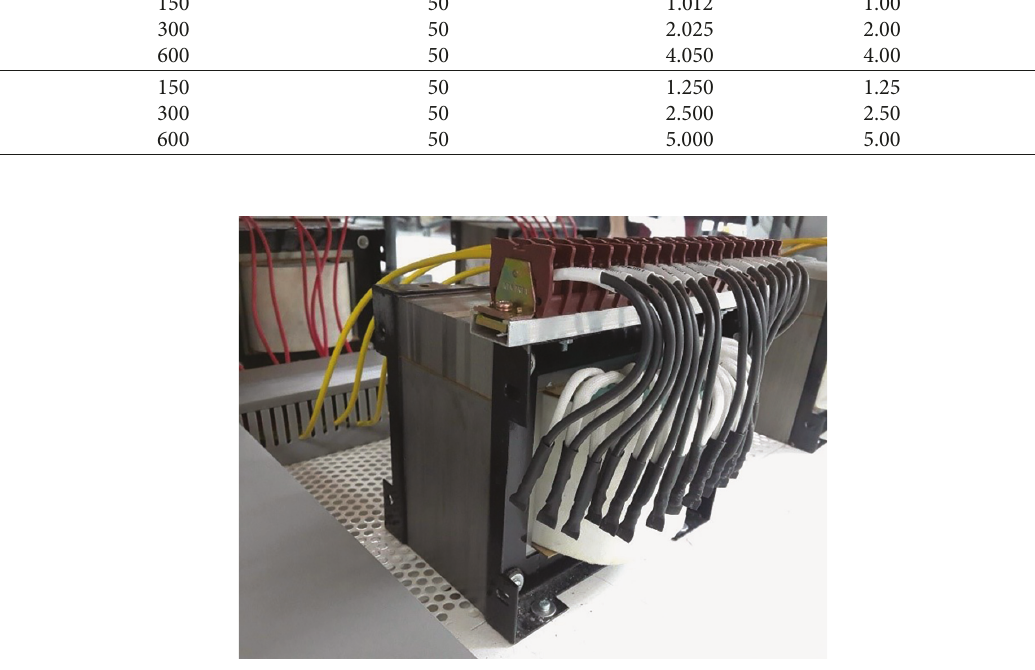
Figure 10: Inductors of the HVDC transmission line. Table 5: Inductance of the HVDC transmission line model at different voltages and distances.